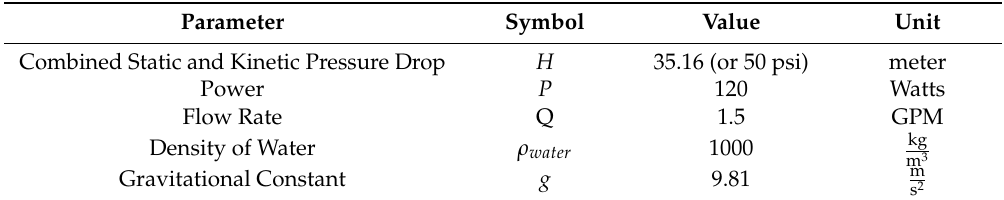
Table 3. Parameters for Equation (8) for a variable speed pump, specifying parameter, symbol used, value and units used. Parameter Symbol Value Unit Combined Static and Kinetic Pressure Drop H